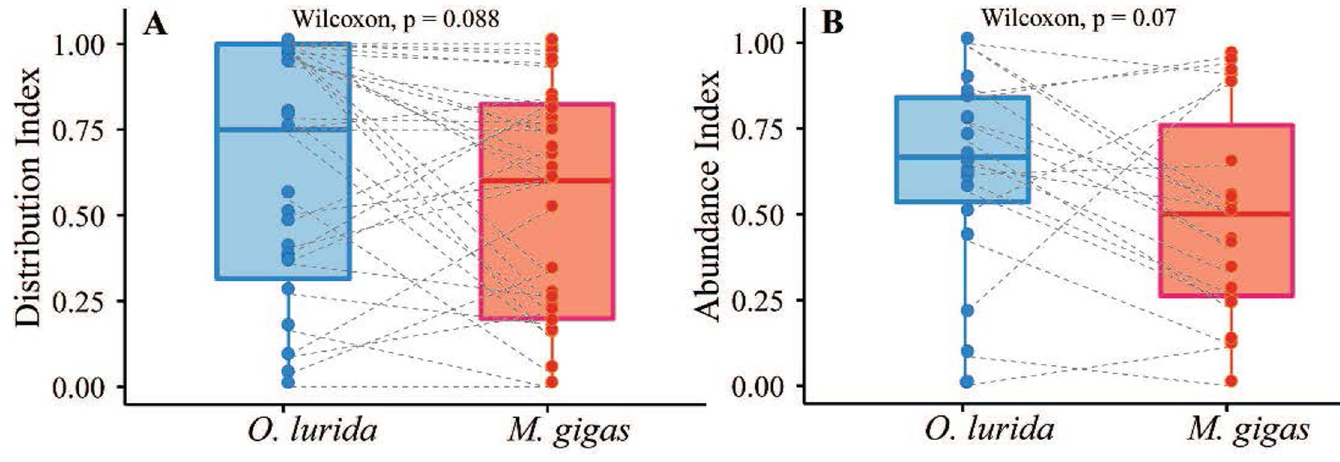
Fig 13. Paired comparisons of distribution and abundance indices between O . lurida and M . gigas in the same estuaries. (A) Distribution index (n = 39 estuaries); (B) Abundance index (n = 19). A dashed line connects records of the two species in the same estuary and p value indicates significance of Wilcoxon test.